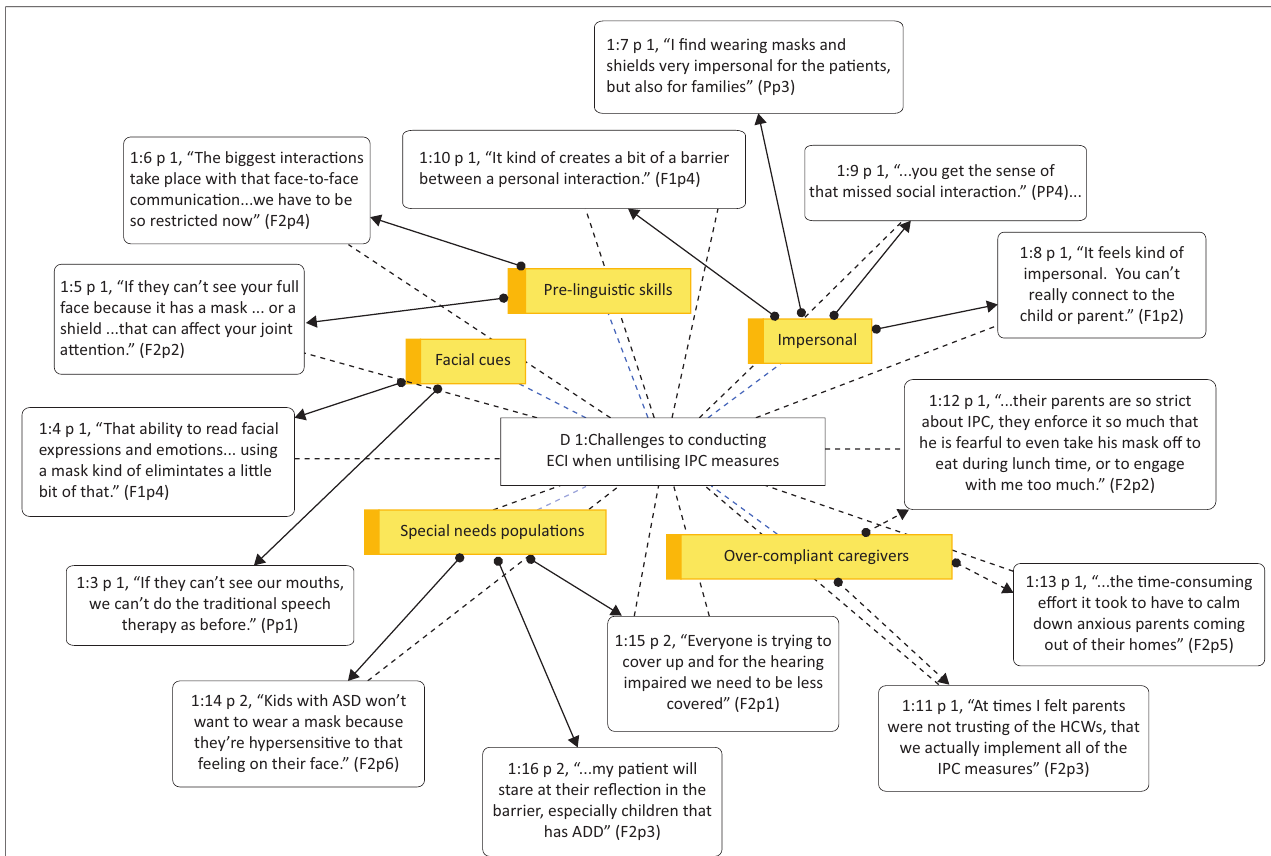
FIGURE 3: Organic network showing the challenges to conducting early communication intervention when utilising infection prevention and control measures as expressed during the focus group discussions, generated by ATLAS.ti version 9.